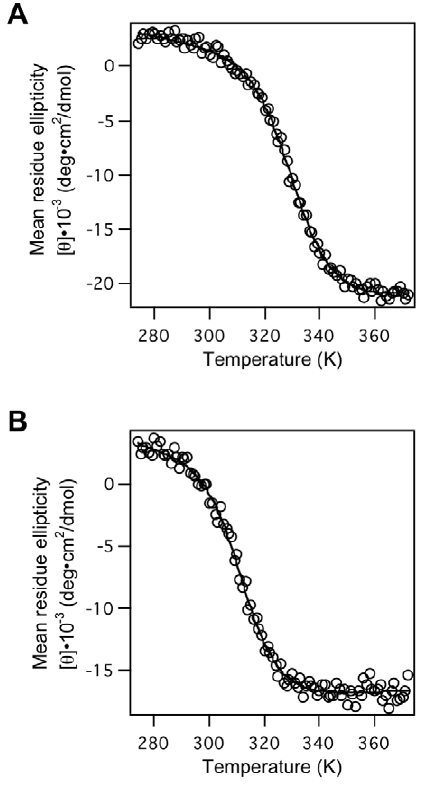
Figure 8. Thermal unfolding curves of selected proteins. The CD mean residue ellipticity values at 220 nm for (A) R13 and (B) N17 were monitored as a function of temperature. The solid curves are the best fit of the whole set of data to eq. 1 (Materials and Methods).